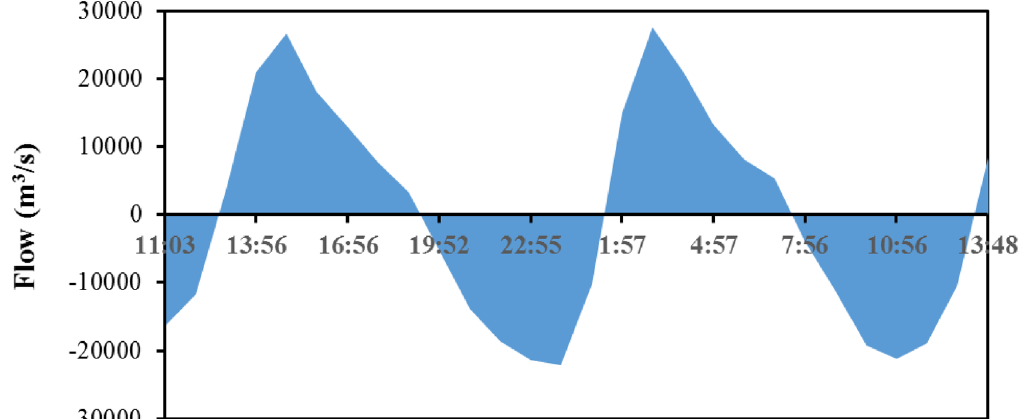
Figure 7. Diurnal flow variations at Jiyu section in the JRE. The figure was prepared using Sigma-Plot Version 10.0 (Systat Software, Inc., San Jose, California,